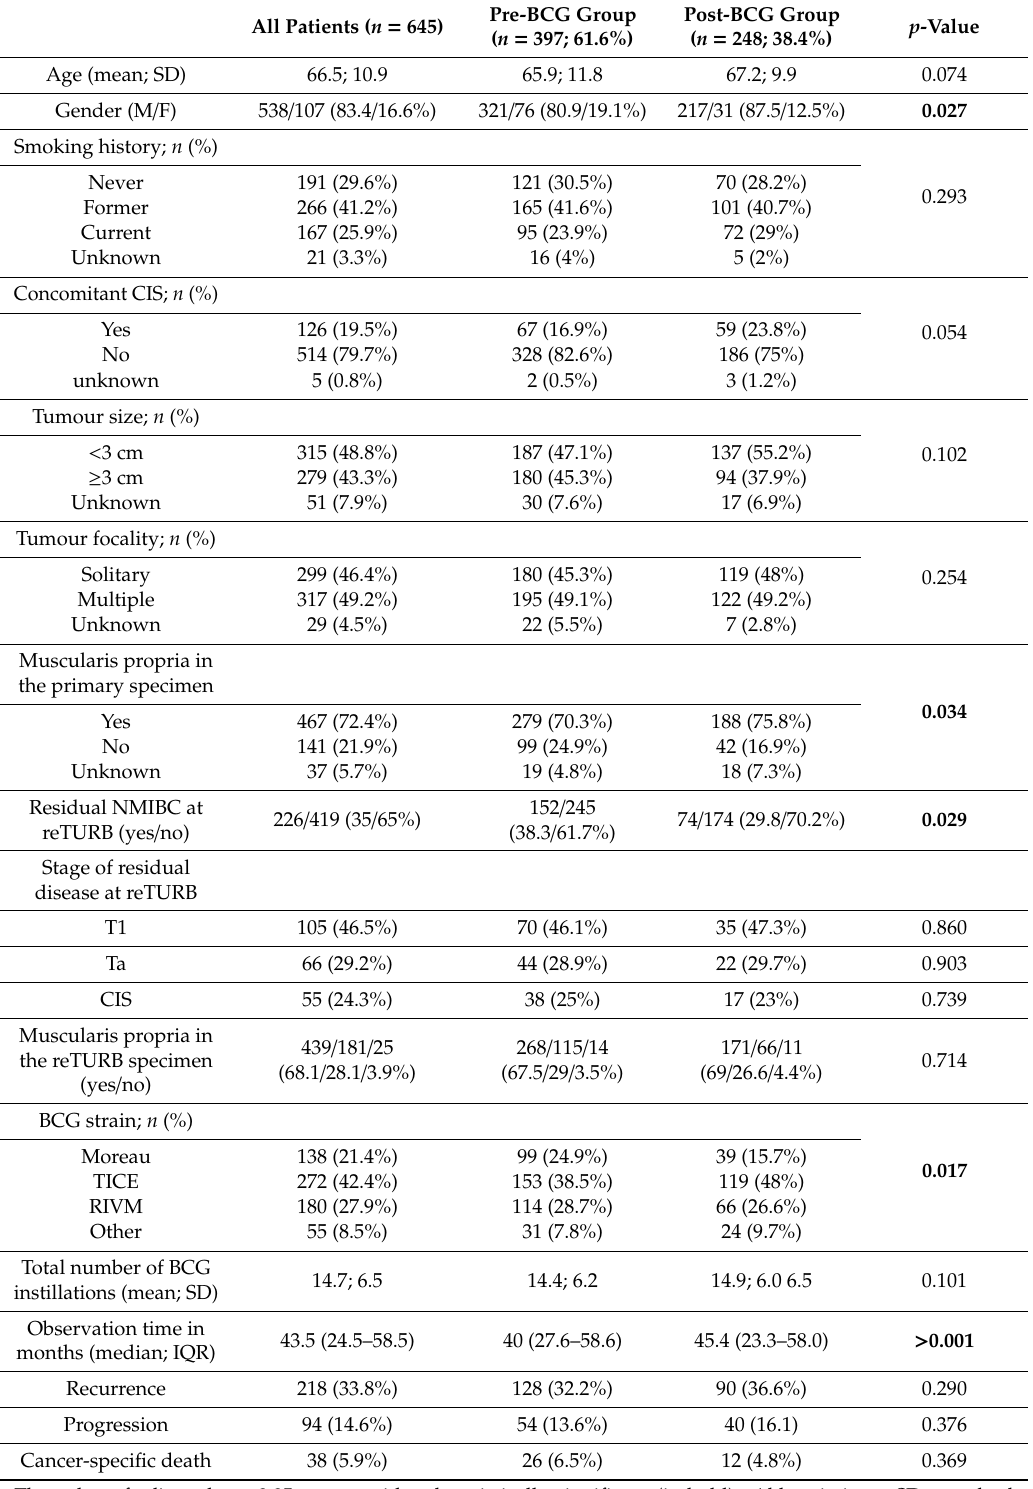
Table 1. The patients’ baseline characteristics. Chi 2 and Mann–Whitney test p -values of the di ff erences between the two study